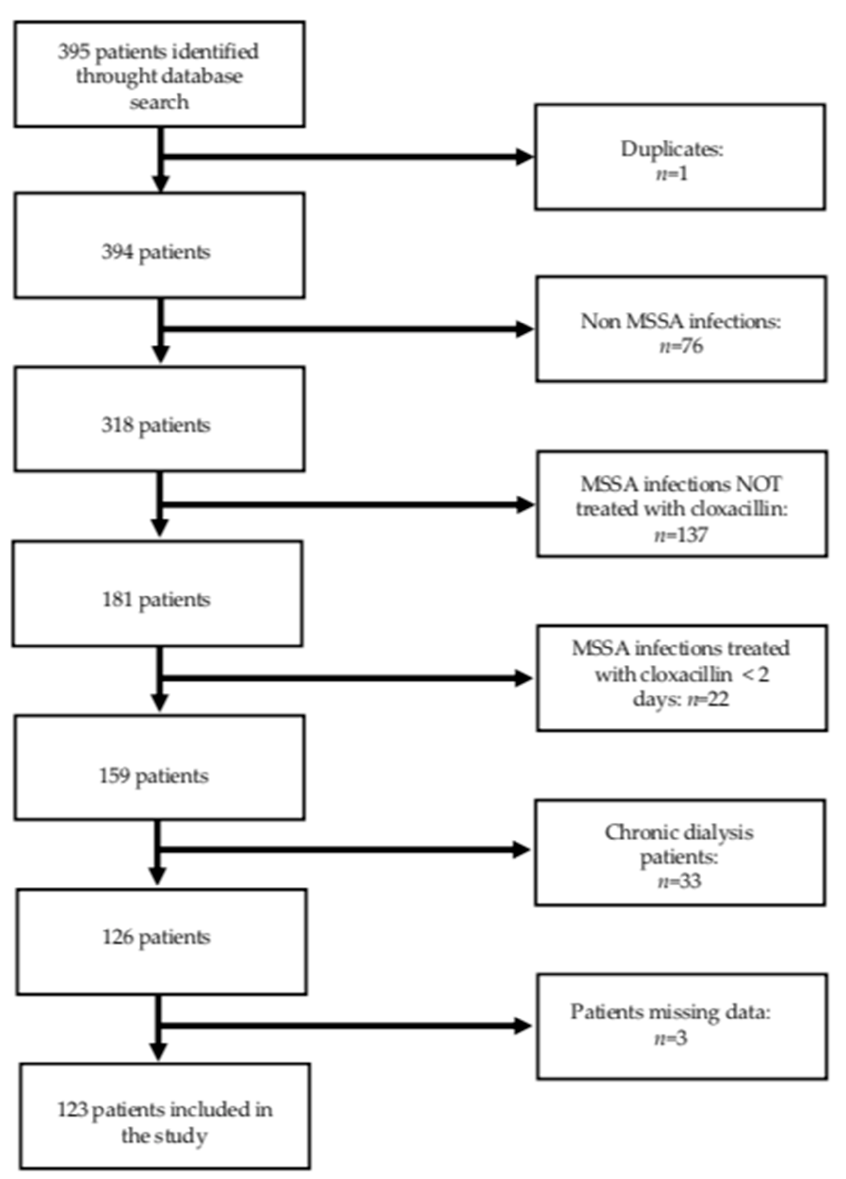
Figure 1. Study flow chart.